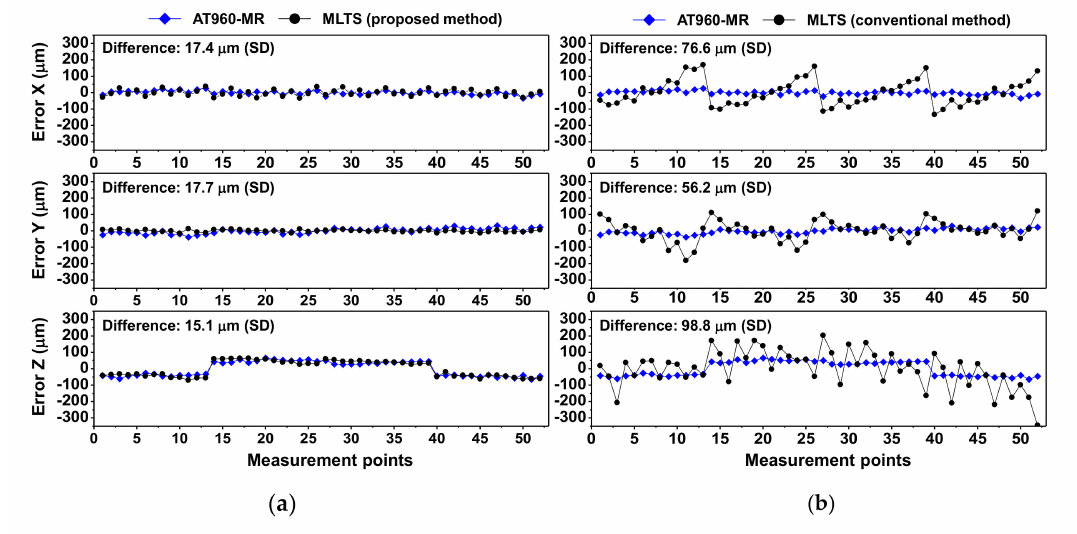
Figure 11. Comparison of coordinate measuring machine (CMM) errors measured by AT960-MR and MLTS in Experiment 1: ( a ) Proposed self-calibration method; ( b ) Conventional self-calibration method.